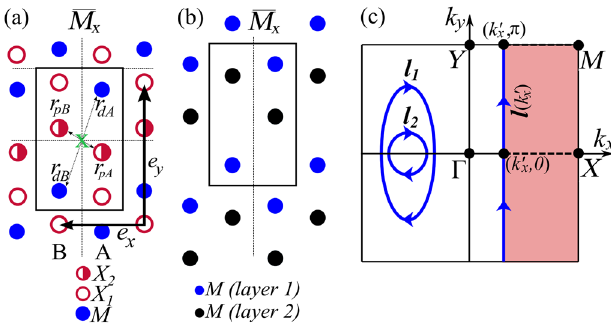
FIG. 2. (a) Crystal structure of a MX 2 monolayer. The ¯ C 2 , the vertical horizontal lines are invariant under the screw x ¯ M line is invariant under , and the green cross indicates the center x of inversion and also our choice of spatial origin. Within each unit cell (encircled by the rectangle), we divide the four X atoms into two pairs marked X - 1 and X - 2 . The X - 2 atoms are further divided into two sublattices labeled by A and B. r l , with l ∈ f d; p g and ;s s ∈ f A; B g , are vectors connecting the origin to the centers of the Wannier functions that we introduce in Sec. IVA. (b) Crystal structure of a MX 2 bilayer, where only the M atoms are